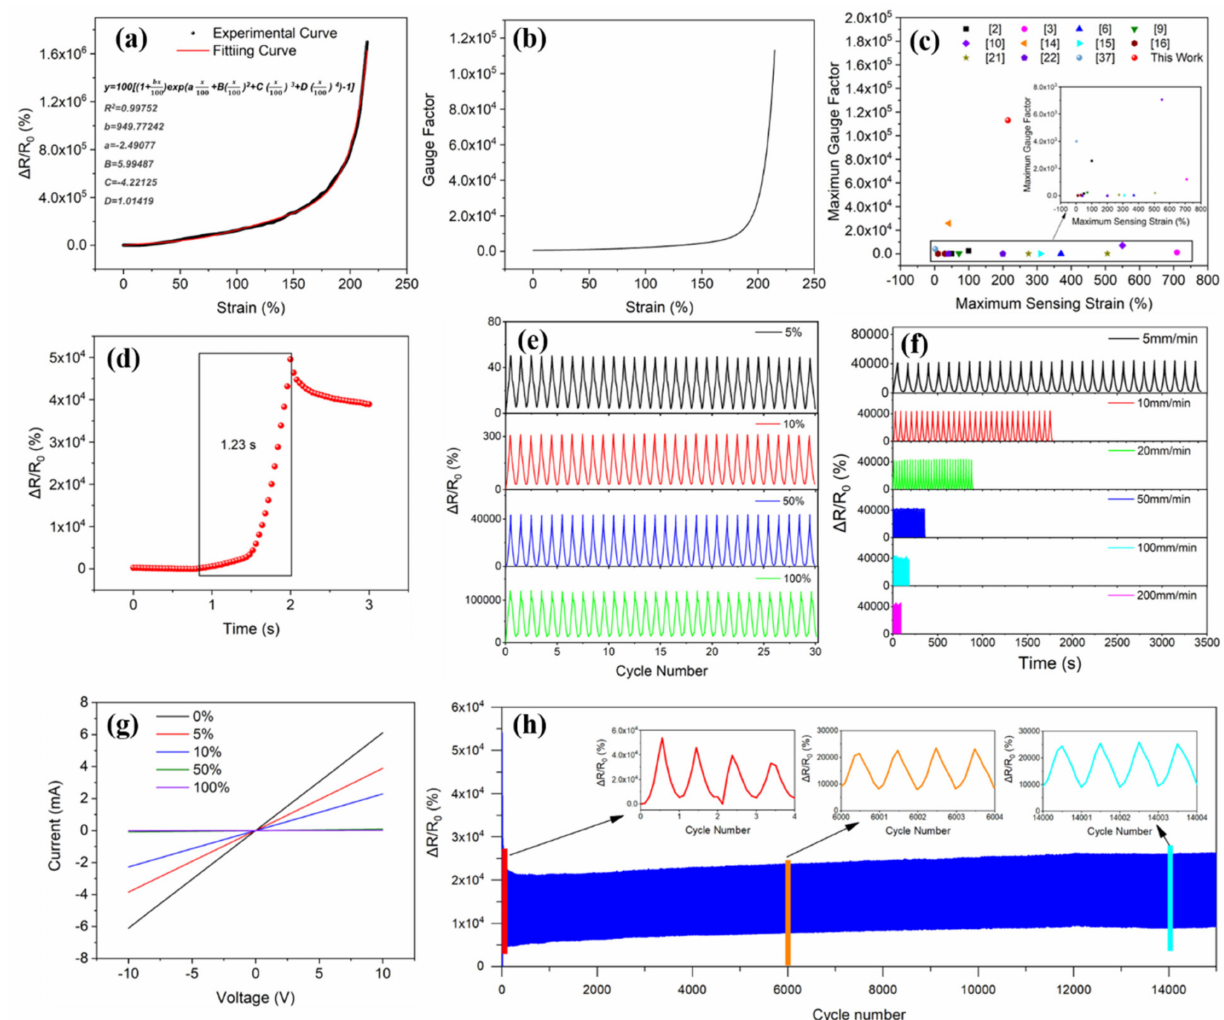
Figure 7. ( a ) The relative resistance change–strain curve of PDA@SEBS/MWCNTs yarn at a stretching speed of 10 mm/min. ( b ) The gauge factor–strain curve of PDA@SEBS/MWCNTs yarn at a stretching speed of 10 mm/min. ( c ) Comparison of the maximum GF and the maximum sensing strain reported in the literature in recent years and those in this work. ( d ) The response time of PDA@SEBS/MWCNTs yarn. ( e ) The relative resistance change of PDA@SEBS/MWCNTs yarn under different strains of 5%, 10%, 50%, and 100% at a stretching speed 10 mm/min. ( f ) The relative resistance change of PDA@SEBS/MWCNTs yarn under different stretching speeds of 5, 10, 50, 100 and 200 mm/min at a strain of 50%. ( g ) Current and voltage of PDA@SEBS/MWCNTs yarn under strains of 0%, 5%, 10%, 50%, and 100%. ( h ) 15,000 cycles in the strain range of 0 to 50% at a frequency of 0.25